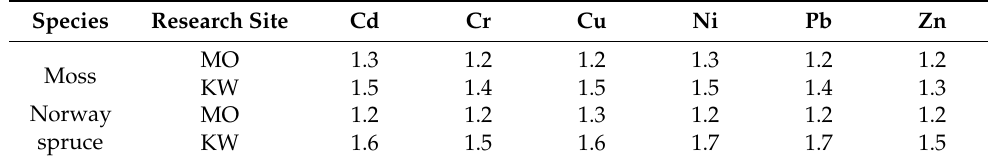
Table 3. Heavy metal content in plants for extreme